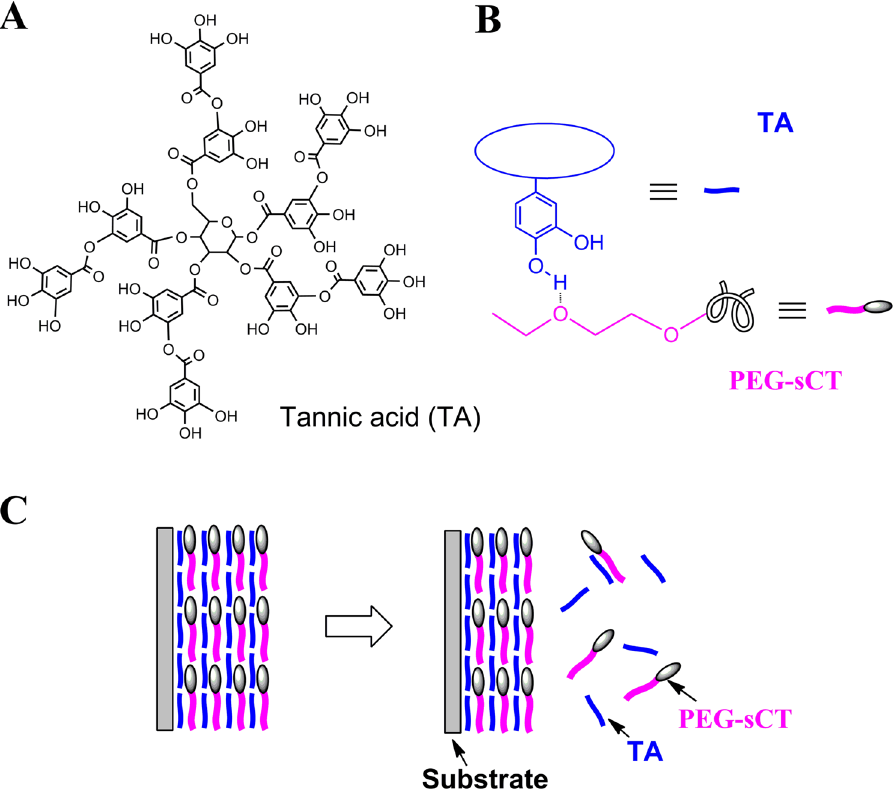
Figure 1. ( A ) Chemical structure of TA. ( B ) Hydrogen bonding between TA and PEG-sCT. ( C ) Release of PEG-sCT from the hydrogen-bonded PEG-sCT/TA film as a result of the gradual disintegration of the